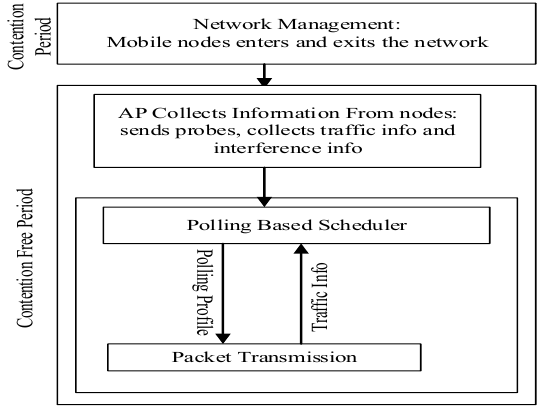
Figure 4. pFDMAC activity during two different timing periods.